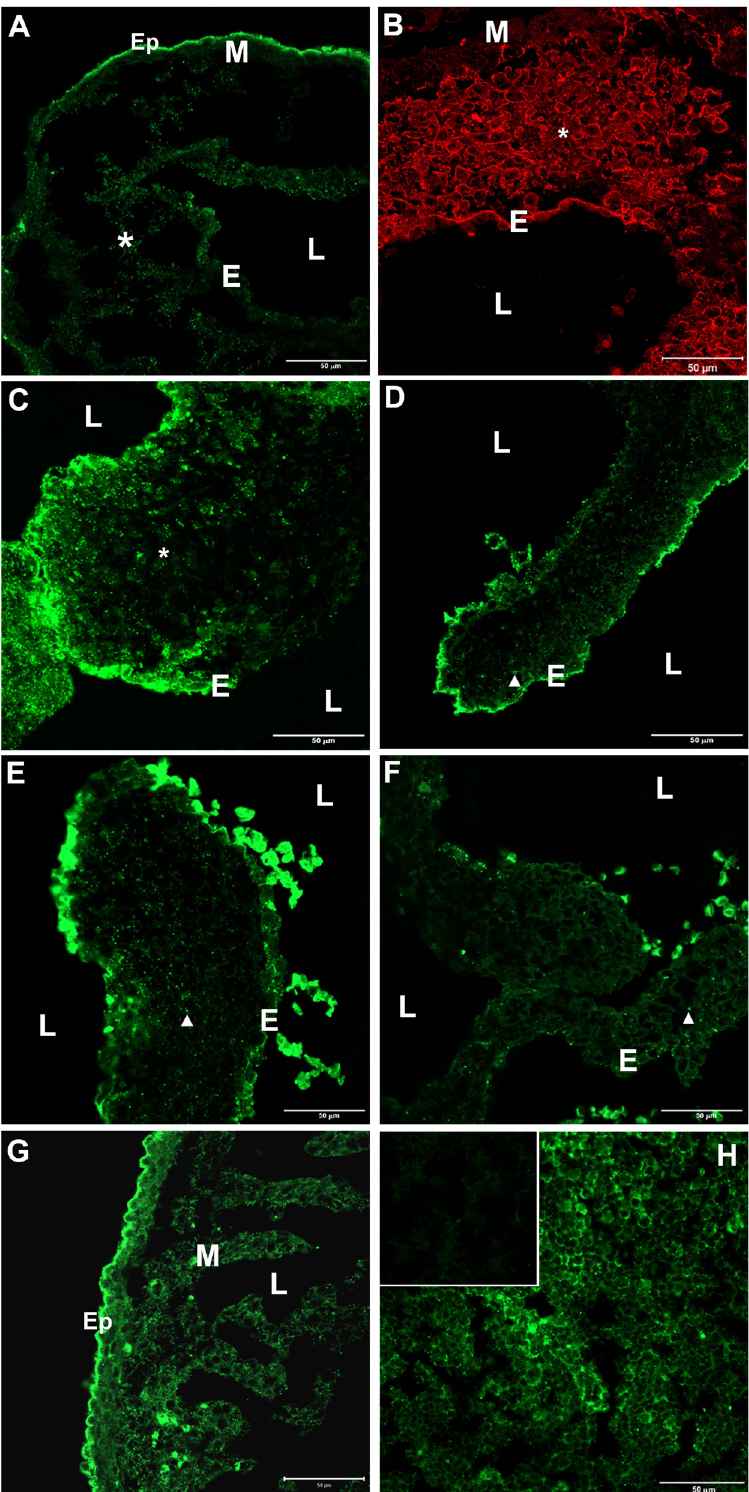
Figure 2. Immunofluorescent localiza - tion of β2 integrin in mouse tissue. A-G , Sections of embryonic mouse hearts: A , ED10.5; B , ED11.5; C , ED13.5; D , ED15.5; E , ED17.5; F , ED19.5; G , ED15.5. Identi- cal patterns of β2 integrin immunostaining were obtained using the N- or C-terminal- specific anti-β2 integrin antibodies (data not shown). Secondary antibody control sections of embryonic hearts, which were included in every experiment, displayed no signal. β2 was present in endothelium (E), epicardium (Ep), myocardium (M), mesenchymal cells in the cardiac jelly (*), and fibroblast-like cells in valve leaflets (arrowheads). Immunolabeled myocardial cells were observed in both the mural and trabecular portions of the myocardium (G). Intensely positive cells were occa- sionally seen within the lumen (L) of the heart in some sections (D-F). These cells were not characterized, but may represent hematopoietic cells, hemangioblasts, or endothelial progenitor cells (see text). H , Sections of 1-month-old mouse thymus. β2 integrin was localized on the cell sur - face of thymocytes. H (inset), Control sec- tions in which the primary antibody was omitted displayed only a low level of auto- fluorescence signal. ED = embryonic day. Magnification bars = 50